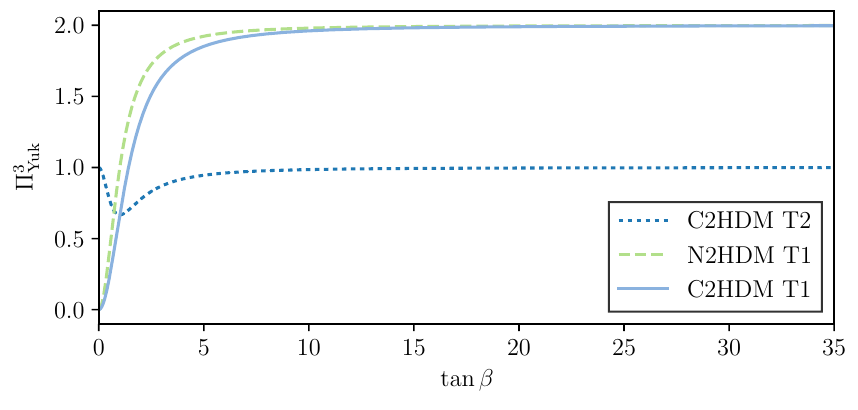
Figure 13 . The non-trivial Yukawa sums for the C2HDM type II (short-dashed blue), eq. (6.9), the N2HDM type I (dashed green), eq. (6.10) and the C2HDM type I (full blue), eq. (6.11), as a function of tan (cid:12)